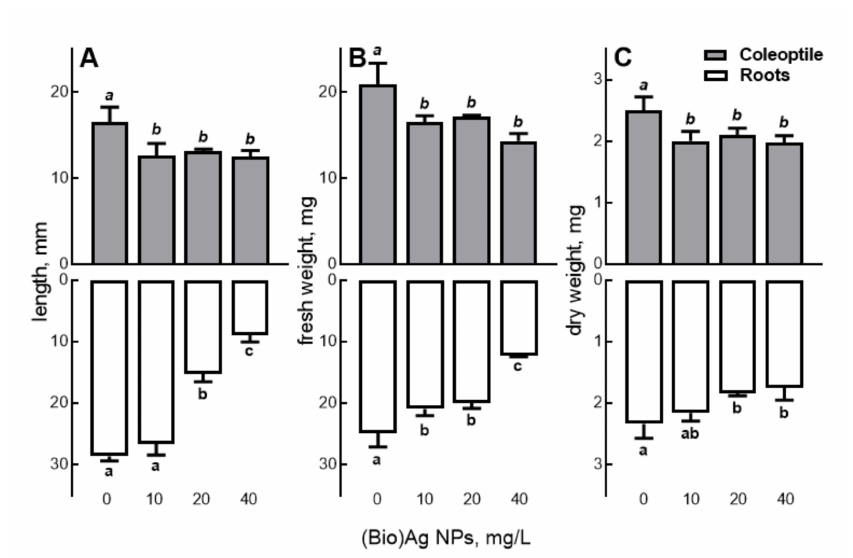
Figure 3. The effect of (Bio)Ag NPs on the length of primary seminal root and coleoptile ( A ), fresh weight (FW, B ), and dry weight (DW, C ) of roots and coleoptile of a 3-days-old seedling of wheat ( Triticum aestivum L., cv. ‘Ostka Strzelecka’). Control grains germinated in double-distilled water. Values are means ( n = 3) ± SD. Bars with the same letters (a–c, a–b ) are not significantly ( p < 0.05) different after the ANOVA test and Tukey’s post hoc corrections. On graph A, the length of the primary seminal root is